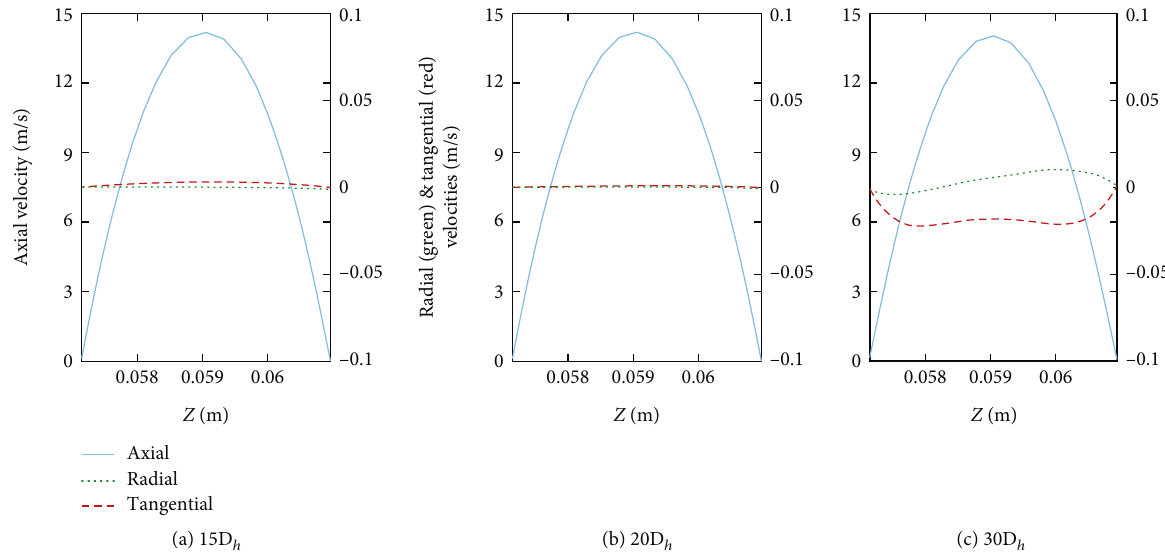
Figure 3: Distributions of fl ow velocities on one side of the cross-section of the well annulus for the case L = 30 D radial, and tangential velocities for L = 15 D